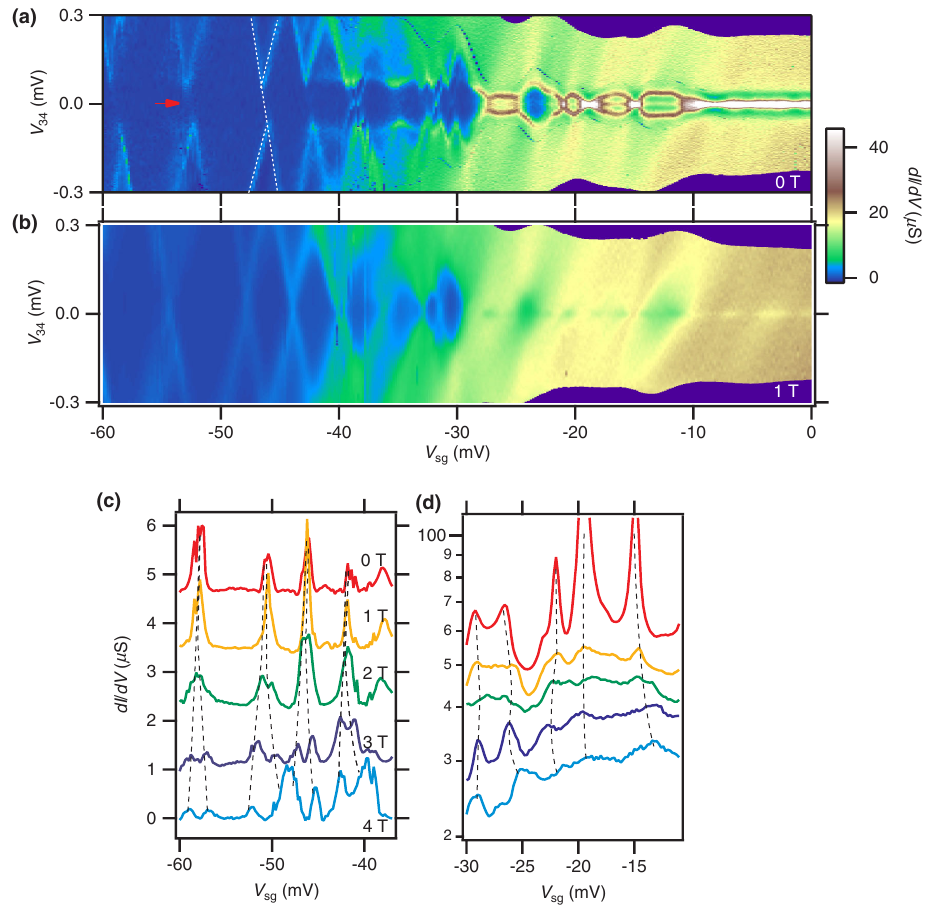
FIG. 2. Transport characteristics. At T ¼ 50 mK, dI=dV is measured as a function of V 34 and V at (a) B ¼ 0 T and (b) B ¼ 1 T. The sg dashed line in (a) is a guide to the eye showing how the diamonds are offset. The fact that the diamonds can be connected by a straight line indicates that one lead has a gap while the other is not gapped. The red arrow indicates the location of zero-bias peak. (c) Zero-bias < − 35 mV). The ZBPs bifurcate above B line cuts at B ¼ 0 – 4 T in low V range ( − 60 < V ( 1 – 2 T), signifying pair tunneling. c sg sg Curves are shifted by 1 . 16 μ S starting from B ¼ 4 T data for clarity. (d) Zero-bias line cuts at B ¼ 0 – 4 T in high V range sg < − 10 mV). The ZBPs do not bifurcate, signifying single-electron tunneling. Curves are shifted by 7 . 75 μ S starting from ( − 30 < V sg B ¼ 4 T data for